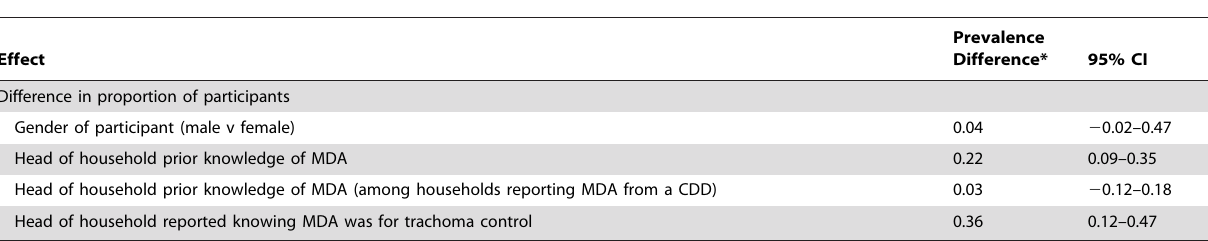
Table 3. Prevalence difference estimates.